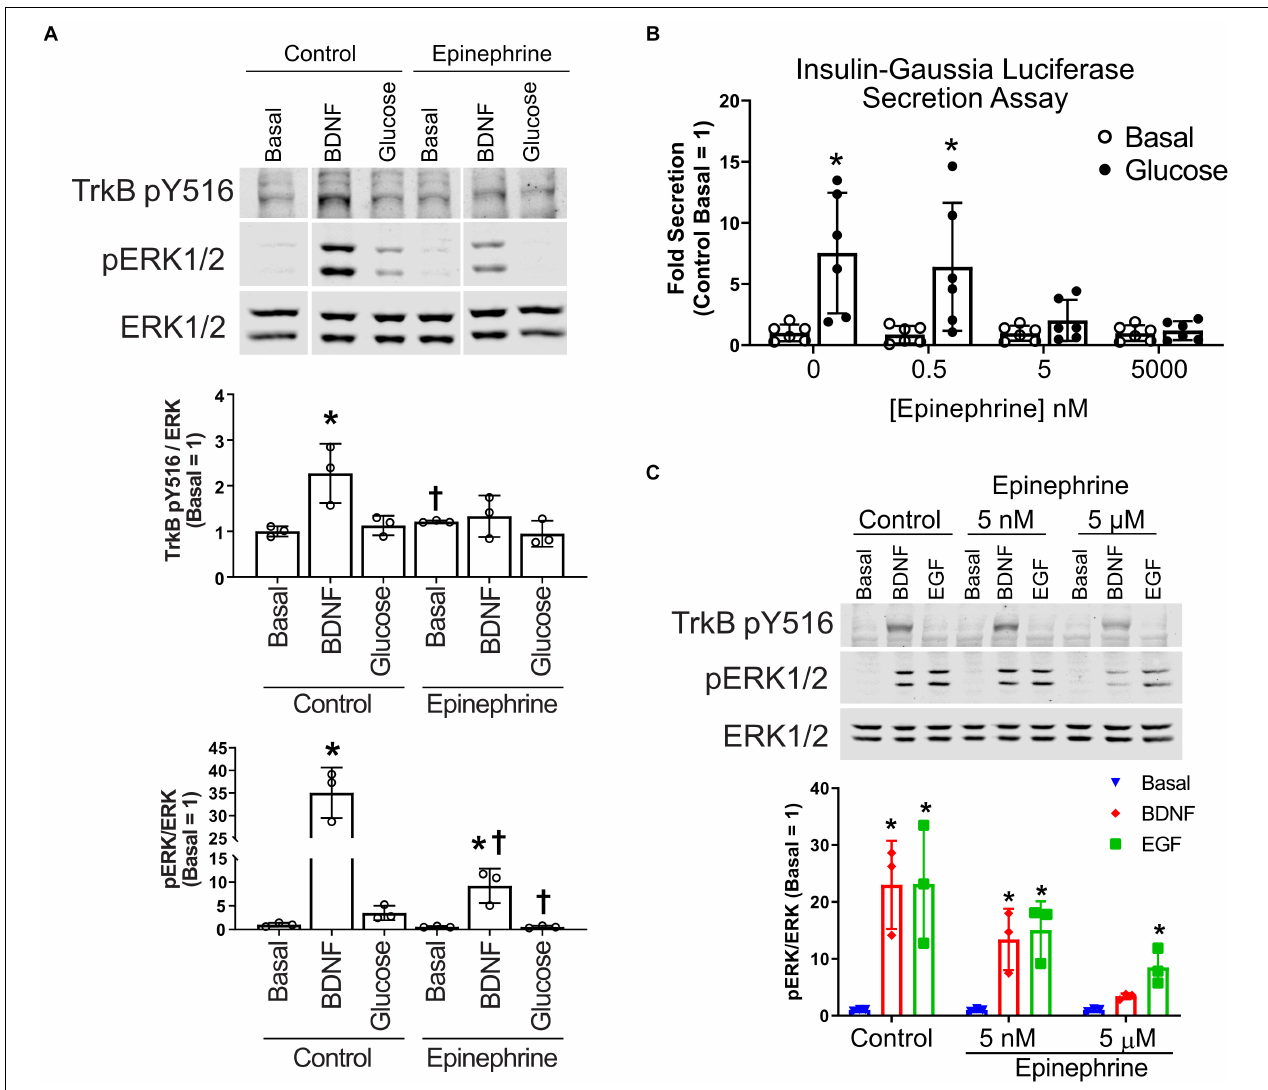
FIGURE 3 | Epinephrine suppresses BDNF signaling to ERK by blocking TrkB activation. (A) To determine if epinephrine affected the upstream activation of TrkB itself, MIN6 cells were preincubated in KRBH containing 2 mM glucose for 1 h 45 min before addition of epinephrine (10 µ M) for 15 min. Cells were then stimulated with BDNF (10 ng/ml) or glucose (20 mM) for 5 min. Western blot analysis shows phosphorylated TrkB (pY516) and ERK1/2 (pERK1/2) normalized to total ERK1/2 ( N = 3). Vertical white lines indicate that intervening lanes have been spliced out. * P < 0.05 vs. respective basal. † P < 0.05 Control vs. Epinephrine by Student’s t -test. (B) InsGLuc-MIN6 cells were preincubated in glucose-free KRBH for 1 h followed by stimulation with glucose (20 mM) in the presence or absence of epinephrine (0.5 nM, 5 nM, or 5 µ M) for 1 h. Supernatant was collected for Gaussia luciferase assays and the data are reported as the fold change with respect to basal unstimulated cells ( N = 6). All graphs are the mean ± SD. * P < 0.05 Basal vs. Glucose by two-way ANOVA using Dunnett’s multiple-comparison test. (C) MIN6 cells were treated as in panel (A) ; however, the cells were pretreated with either 5 nM or 5 µ M epinephrine prior to stimulation with EGF or BDNF for 5 min. Western blot analysis shows only 5 µ M epinephrine suppressed pTrkB ( N = 2) and pERK1/2 ( N = 3) signaling by BDNF. Bar graph is the mean ± SD. * P < 0.05 vs. respective Basal by two-way ANOVA using Dunnett’s multiple-comparison